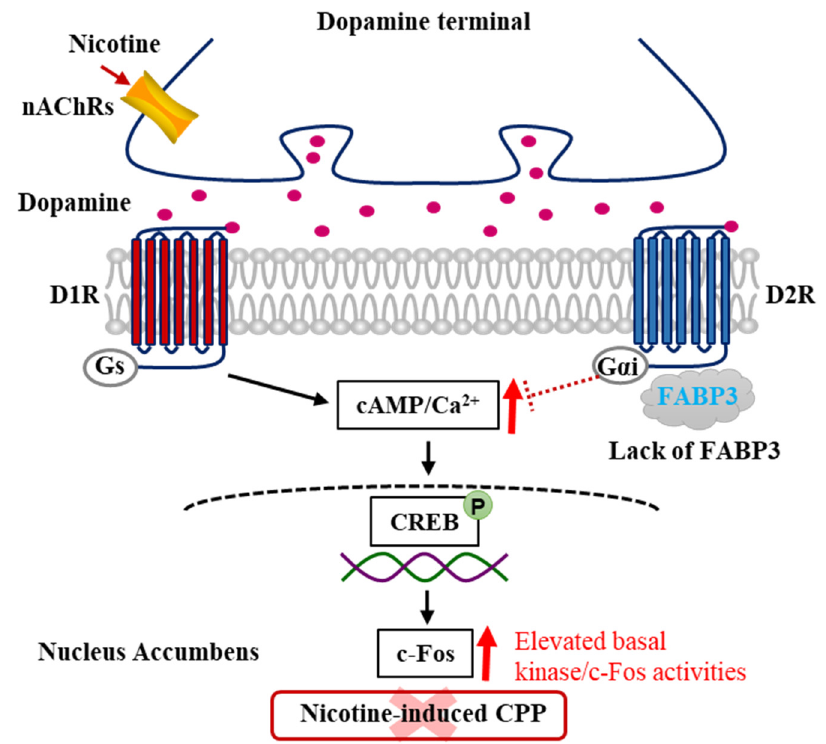
Figure 3. Schematic model of dopamine signaling pathways underlying nicotine-induced addiction in the FABP3 − / − mice NAc. In FABP3 − / − mice, the lowered cAMP/Ca 2+ levels regulated by D2R/FABP3 signaling derepresses due to the impaired D2R function through the lacking FABP3, which provokes elevated cAMP/Ca 2+ levels and increases CREB/c-Fos signaling. These constitutive elevated cAMP/Ca 2+ levels and signals underlie the mechanism of failed acquisition of nicotine- induced addiction in FABP3 − / −